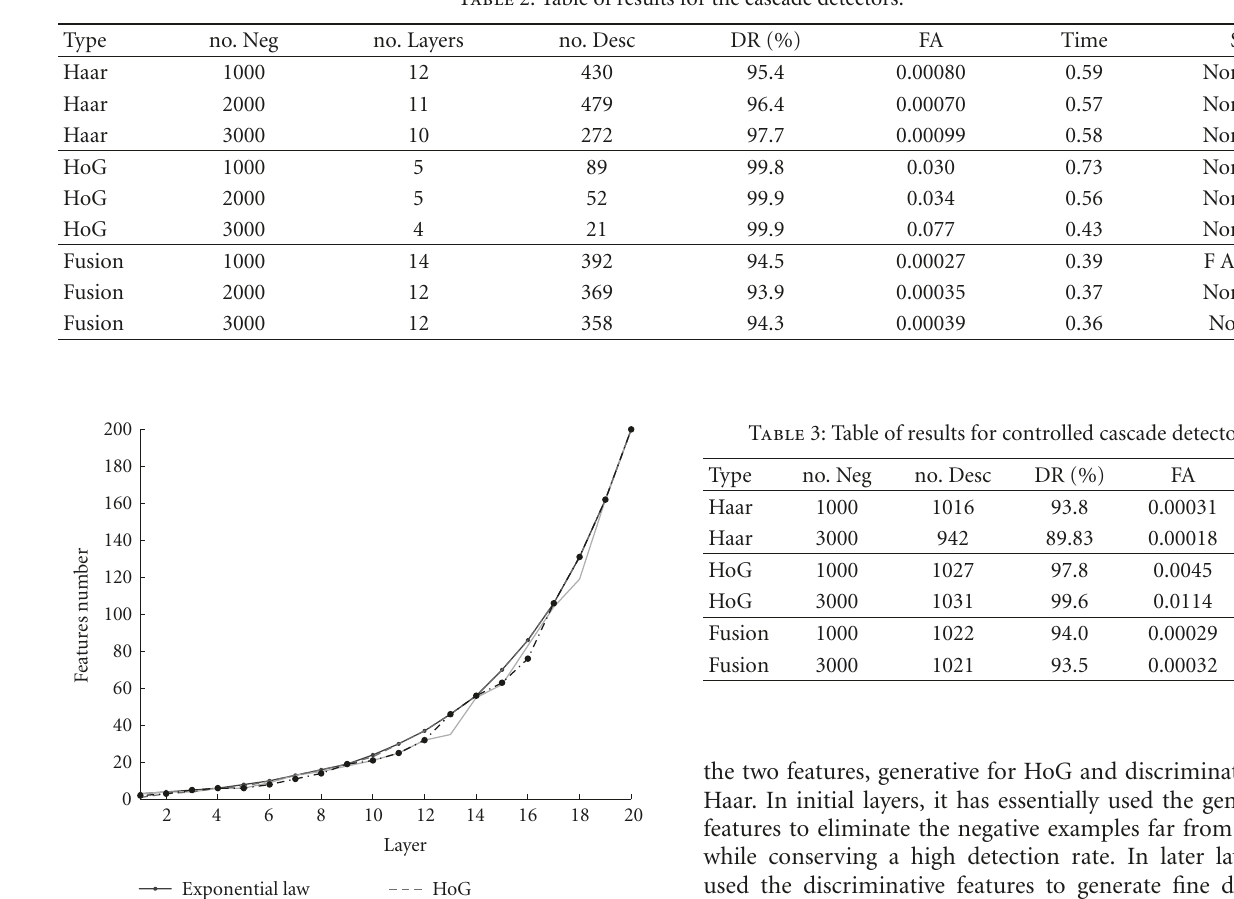
Table 2: Table of results for the cascade detectors.